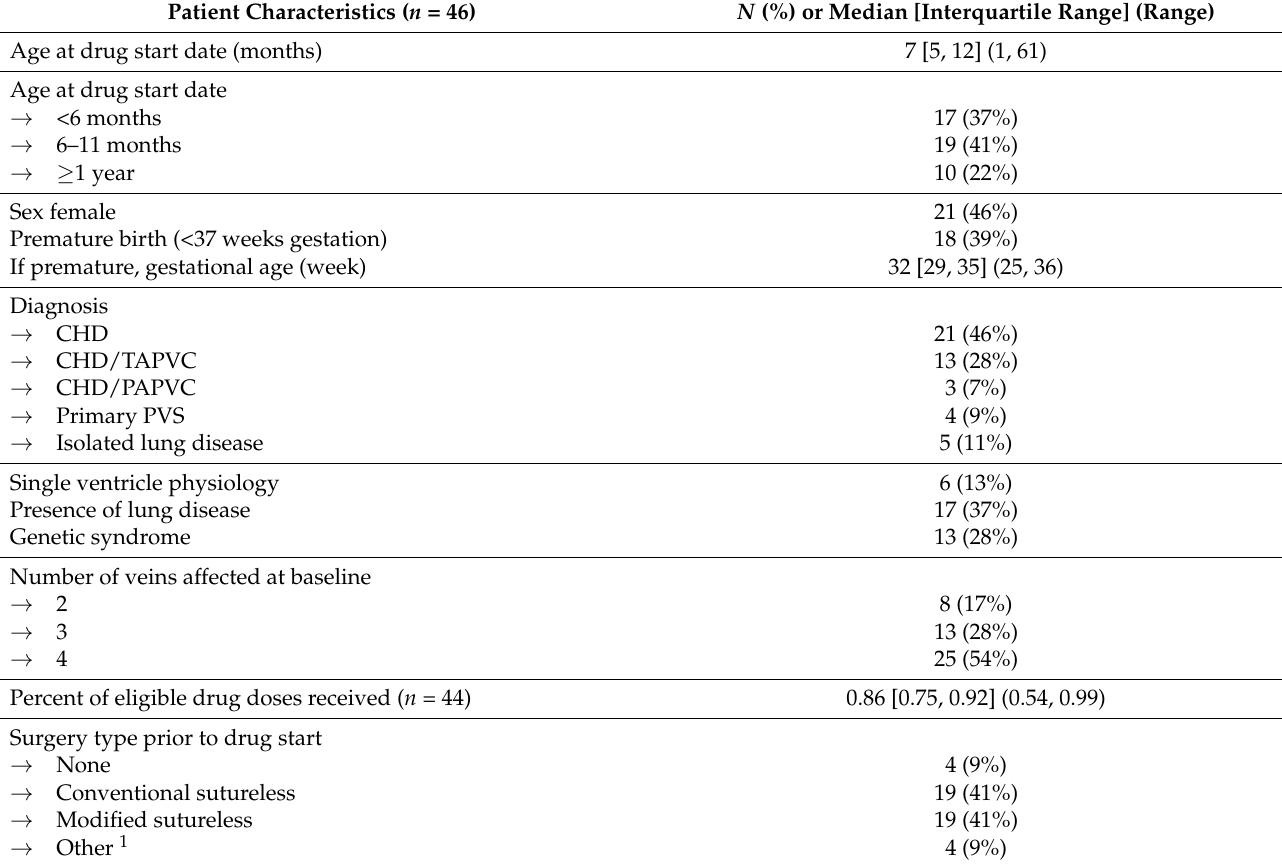
Table 2. Patient